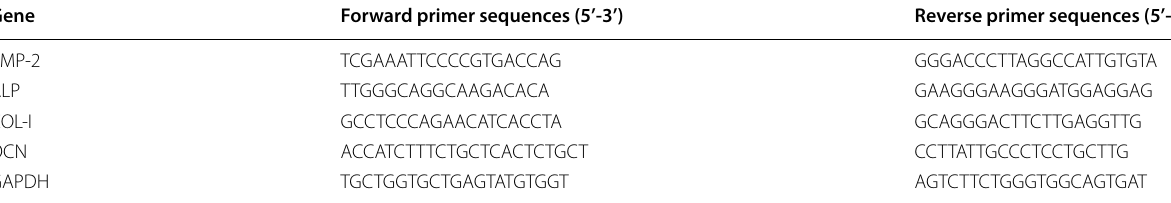
Table 2 qRT‑PCR primers Gene Forward primer sequences